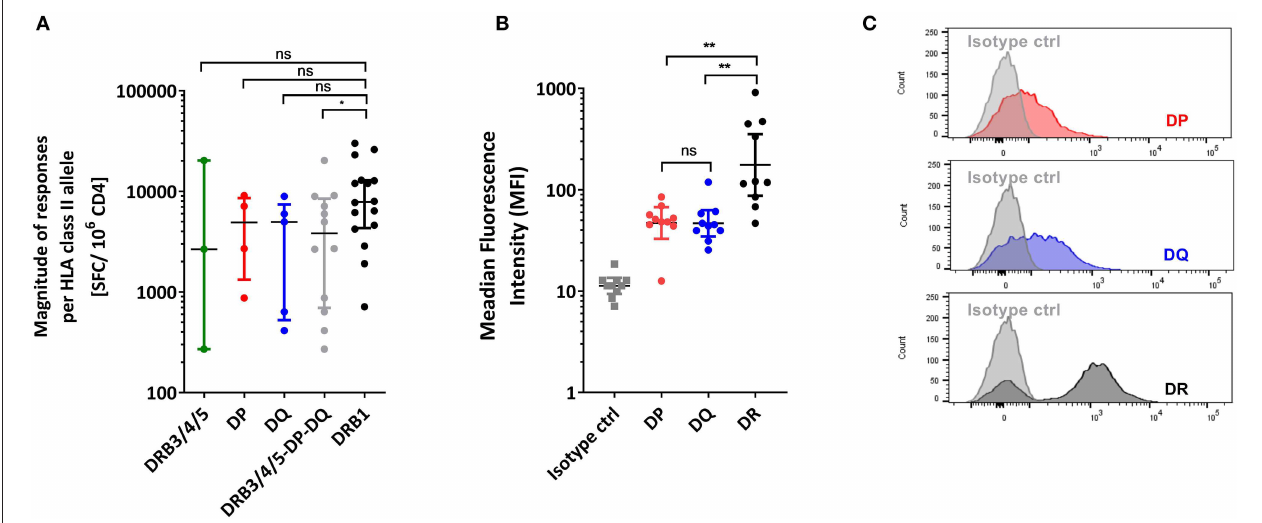
FIGURE 2 | HLA class II loci comparison. (A) Magnitude of CD4 + T cell responses per HLA class II allele expressed as SFC/10 6 CD4 cells/donor after in vitro stimulation. (B) Membrane expression of HLA-DR, DP, DQ molecules in PBMCs expressed as Median Fluorescence Intensity (MFI). All statistical analysis were performed using unpaired non-parametric Mann-Whitney test. * p < 0.05, ** p < 0.01, ns, not significant. (C) Representative overlay histograms derived from one donor PBMCs staining showing the membrane expression of isotype control (gray) overlayed with HLA-DR (black), DP (blue) or DQ (red) molecules, respectively.